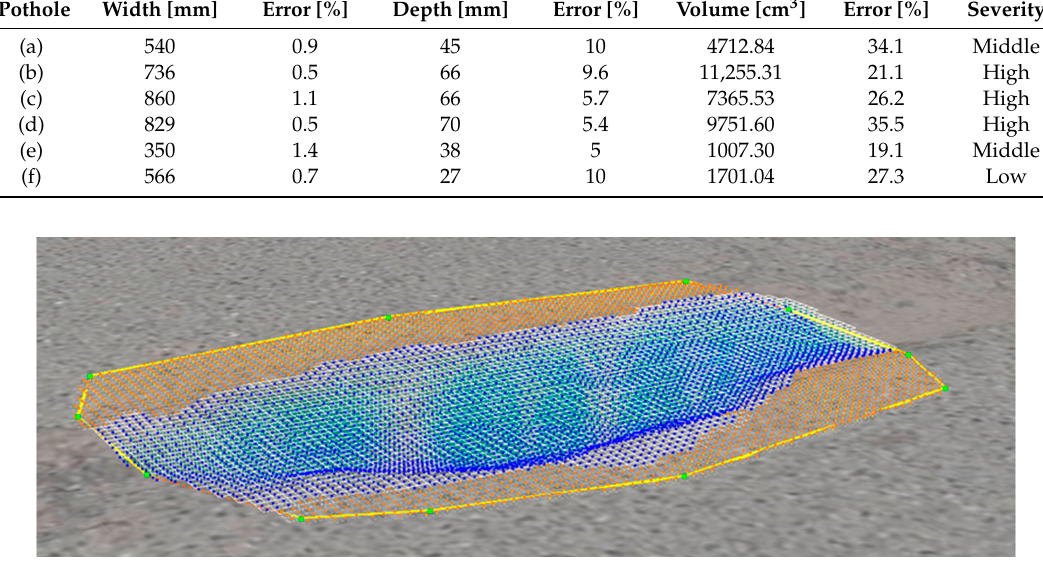
Figure 13. Volumetric representation of a pothole in 3D reconstruction, based on Context Capture (Bentley) software. Table 7. Dimensions of potholes measured in model at 10 m and error.